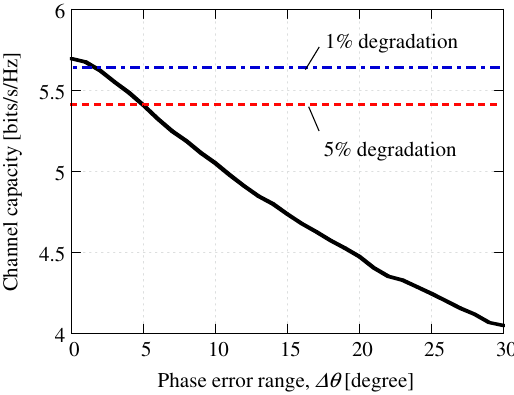
Figure 9. C vs. ∆ θ , with cumulative density function (CDF) of 10%.